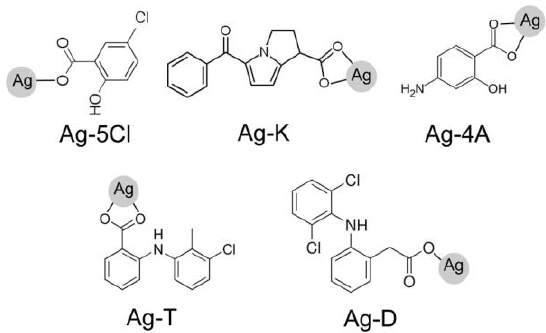
Figure 1. Anti-inflammatory ligands used in the synthesis of silver compounds: Ag-5Cl, Ag-K, Ag-4A, Ag-T, Ag-D, tolfenamic acid (T), ketorolac tris salt (K), sodium diclofenac (D), 5-chlorosalicylic acid (5Cl), and sodium 4-aminosalicylate (4A).